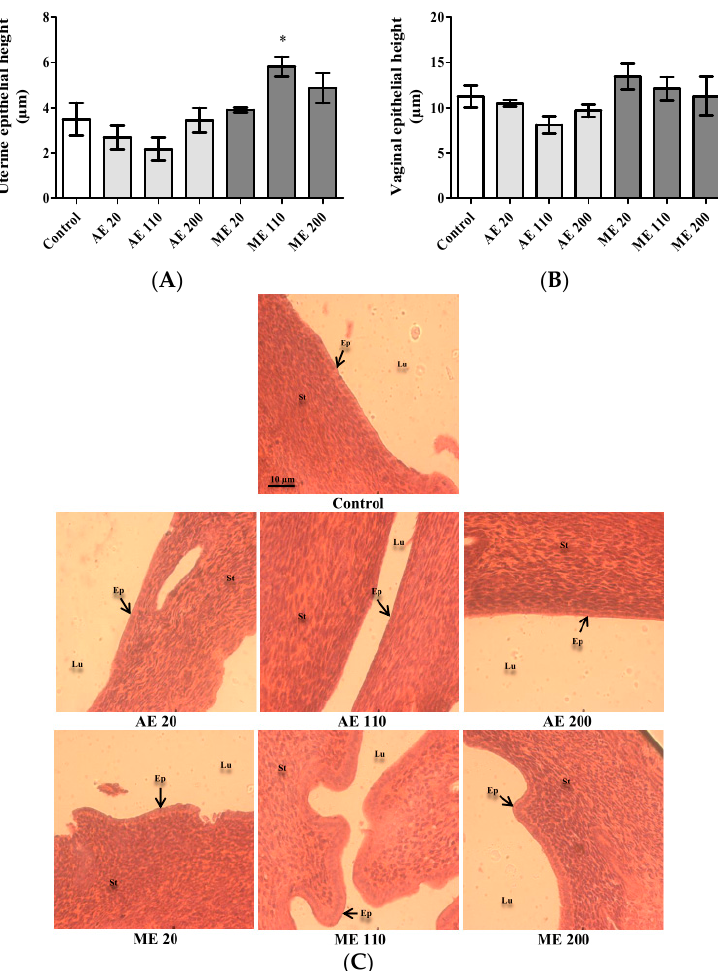
Figure 3. Epithelial height of uteri ( A ) and vagina ( B ) as well as microphotographs of uteri sections ( C ) following treatments. Control = Animals receiving vehicle (distilled water, 10 mL/kg BW); AE = animals treated with the aqueous extract of M. arboreus ; ME = animals treated with the methanol extract of M. arboreus . Lu = lumen; Ep = epithelium; St = stroma. Results are shown as the mean ± SEM; *: p < 0.05 in reference to control.